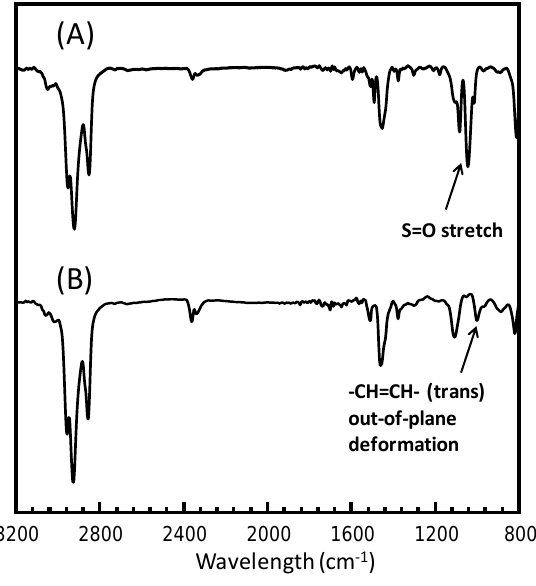
Figure 5. IR spectra of ( A ) PTVS- b -P3HT- b -PTVS and ( B ) PA- b -P3HT- b